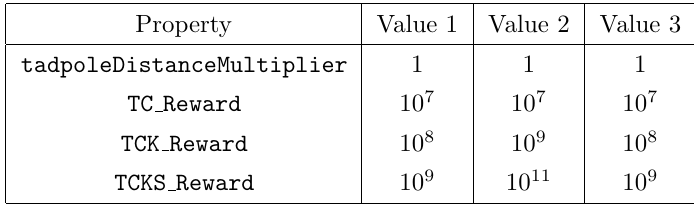
Table 4 . Value assignments for the SM-CONSISTENCY reward function.